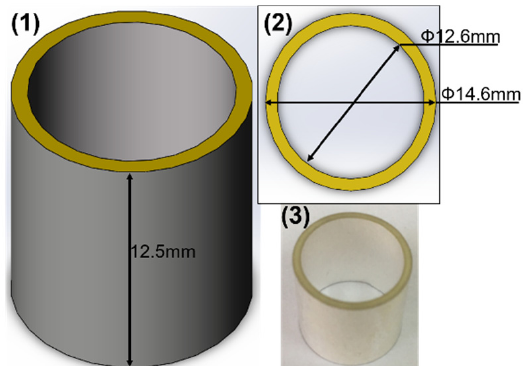
Figure 7. The piezoelectric ceramic tube. ( 1 ) A model in isometric view orientation; ( 2 ) in top-view orientation; ( 3 ) physical picture of piezoelectric tube.